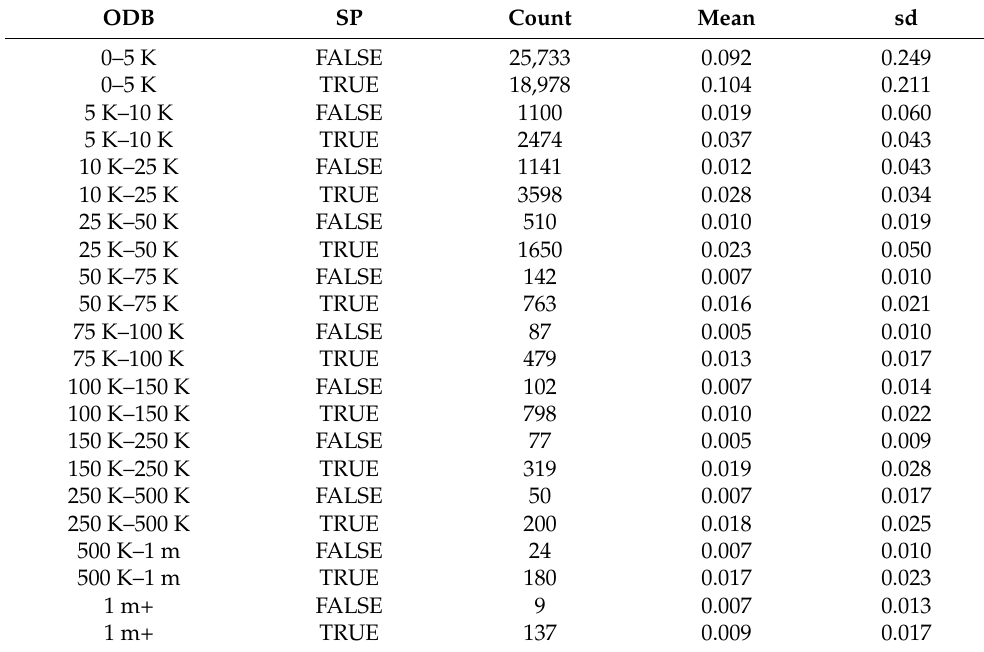
Table 2. Means and standard deviations for engagement as a function of 2 (sponsorship, SP) X 11 (out-degree bucket, ODB)